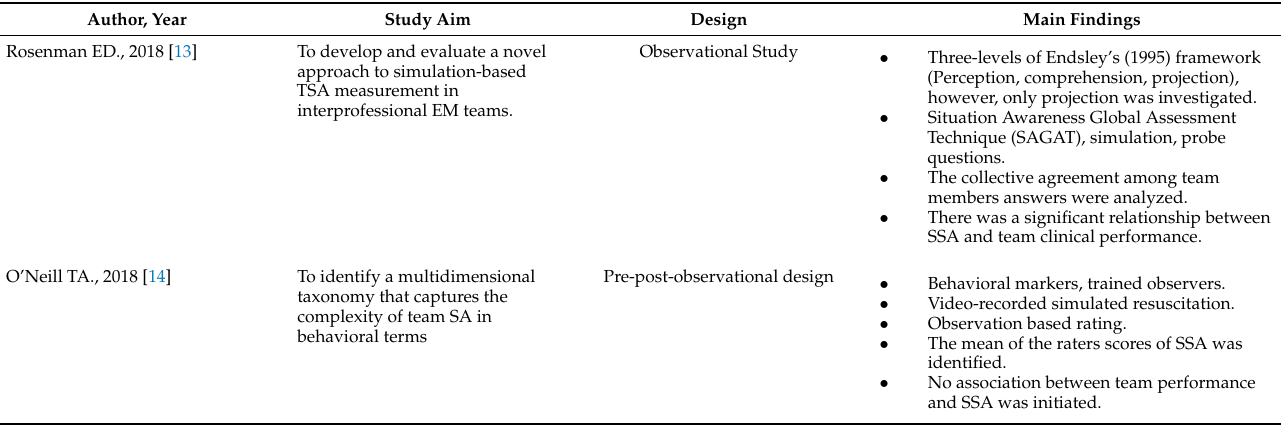
Table 1. Included studies